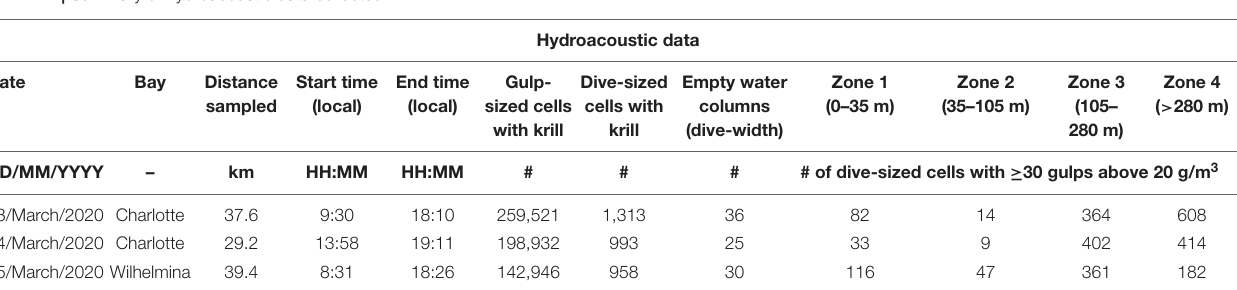
FIGURE 2 | The mobile setup for the ek80 system, in combination with calm waters in the fjords, allows clean data collection. (A) The self-contained mobile system allows for sensitive transceivers to be deployed in open air boats with an independent power-supply (a 12 V deep-cycle marine battery). (B) Unprocessed 120 kHz ek80 data. This system allowed for clean data collection below 500 m depth at 120 kHz. Time-varied gain corrected background noise at 500 m was ∼ -70 dB, implying a signal to noise ratio of > 20 dB even at those depths. Photo credit: Ryan Houston, illustration by Alex Boersma. TABLE 1 | Summary of hydroacoustic data